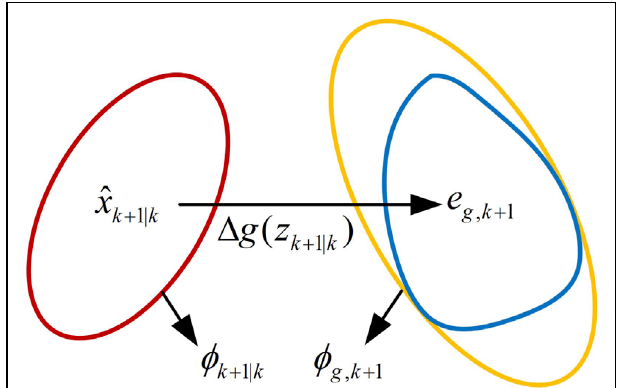
FIGURE 3 | The linearization error